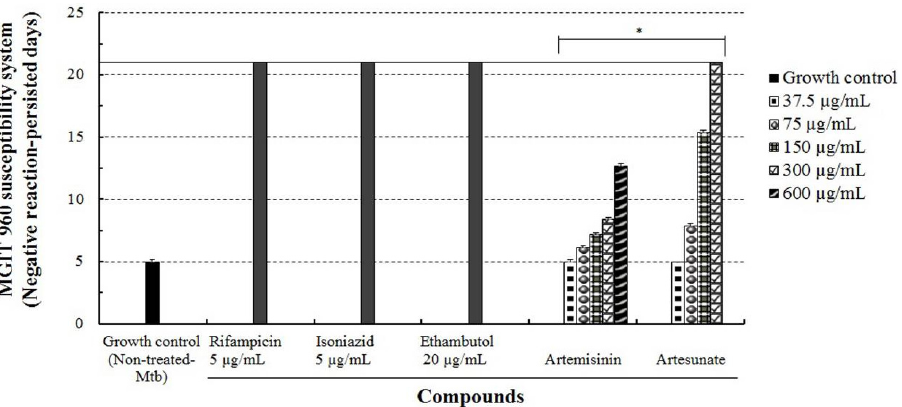
Figure 3. The anti ‐ Mtb effect of artesunate and artemisinin measured using the MGIT 960 system assay. Mtb was incubated with different concentrations (37.5–600 μ g/mL) of the compounds in the MGIT 960 system device at 37 °C for three weeks, respectively. All results were expressed as mean ±